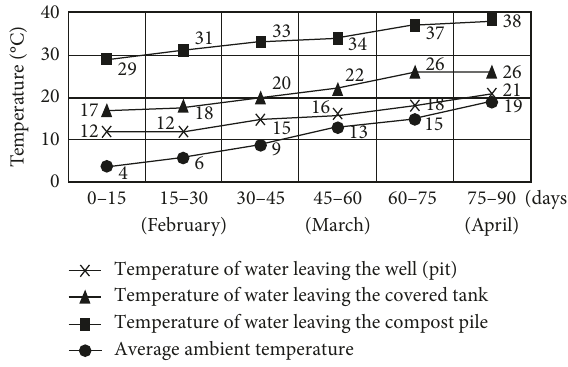
Figure 5: Water temperature data for three